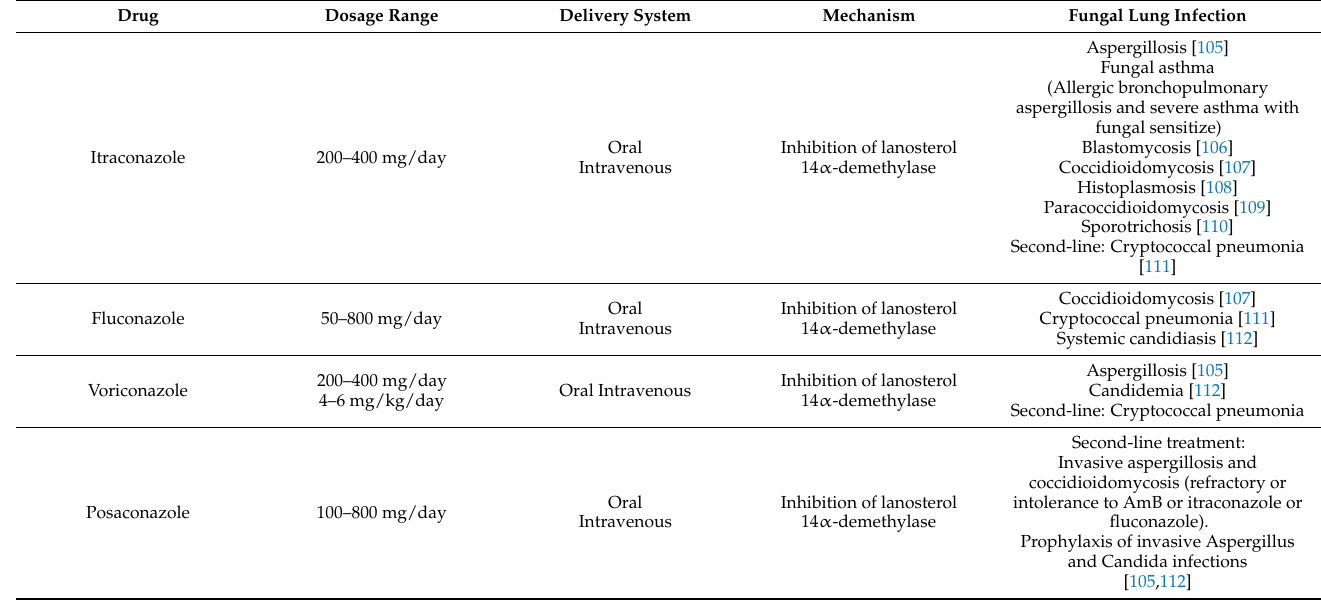
Figure 1. Mechanisms of action of antifungal drugs used in invasive pulmonary fungal infection. ( a ) Azole compounds target the cytochrome P450 enzyme sterol 14 α -demethylase, which converts lanosterol to ergosterol. Inhibition of ergosterol biosynthesis leads to disrupted cell membrane integrity and fungistatic effect. ( b ) Echinocandins inhibits β(1,3)-D-glucan synthase, therefore inhibiting β(1,3)-D-glucan. β(1,3)-D-glucan constitutes more than 50% of the cell wall and is the main structural polysaccharide to which other cell wall components (chitins and glycoproteins) are attached. ( c ) AmB binds to ergosterol through mycosamine interaction, forming ion channels inside lipid bilayers. Another mechanism is the formation of sterol sponges that extract ergosterol from lipid bilayers. Table 1. Therapies for pulmonary fungal disease.